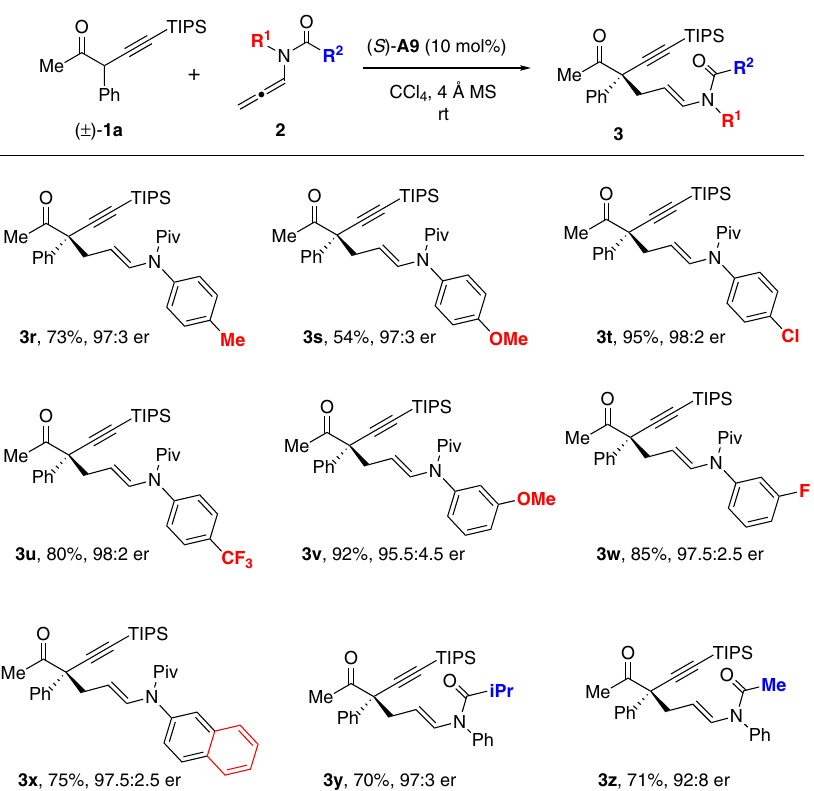
Fig. 3 Substrate scope of allenamides. Reactions were performed with 1a (0.2 mmol), 2 (0.22 mmol), CPA ( S )- A9 (0.02 mmol), activated 4 Å MS (200 mg) in CCl 4 (2 mL) at room temperature. Isolated yields. Er values were determined by HPLC analysis on a chiral stationary phase.